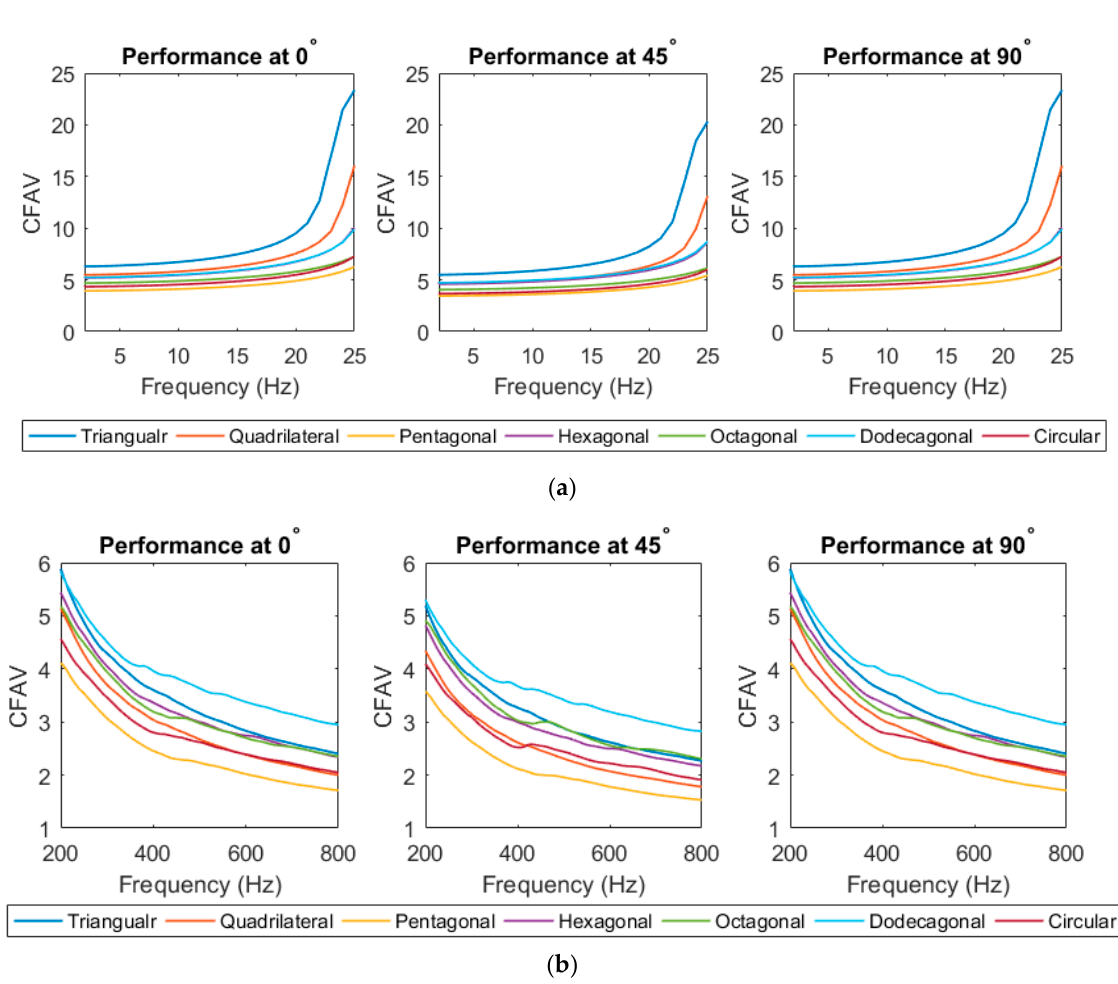
Figure 9. ( a ) frequencies below 25 Hz range ( b ) broadband frequency ranges for single-lamina.